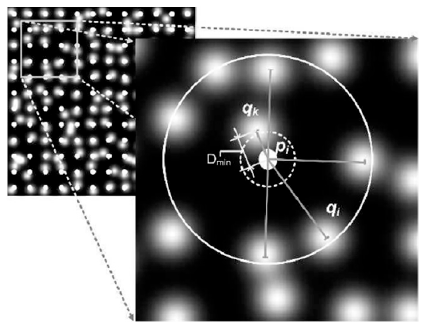
Figure 6. Principle of optimization of Chinese characters for nearest neighbor search. p i is the ideal location for the induced phosphene point of view, q i is the location of the actual induced phosphene, q k is the location of the phosphene induced by another electrode, D min represents the shortest distance (cited from